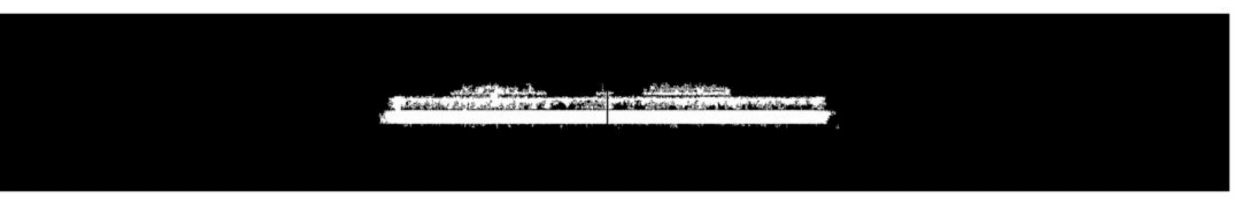
Figure 9. The image after the modified SBGFRLS model in the case of RFI with a single source.